Question: Summarize what this figure shows in one sentence.
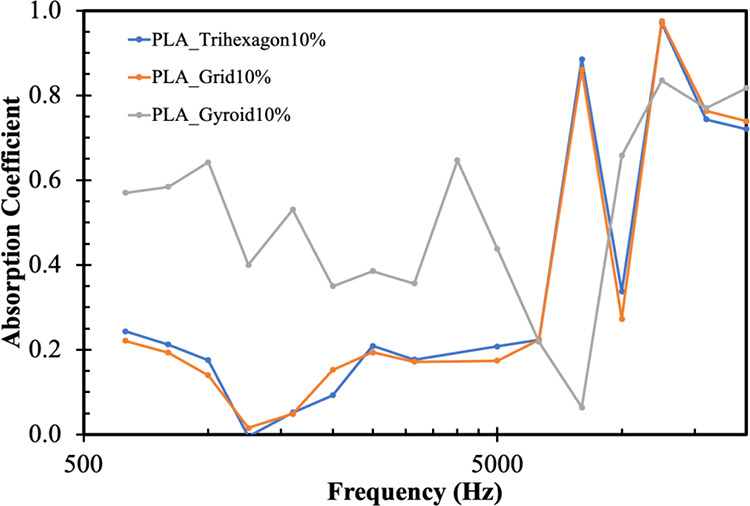
Answer: Sound absorption response of PLA trihexagonal, grid, and gyroid infill structures at 10% infill density.